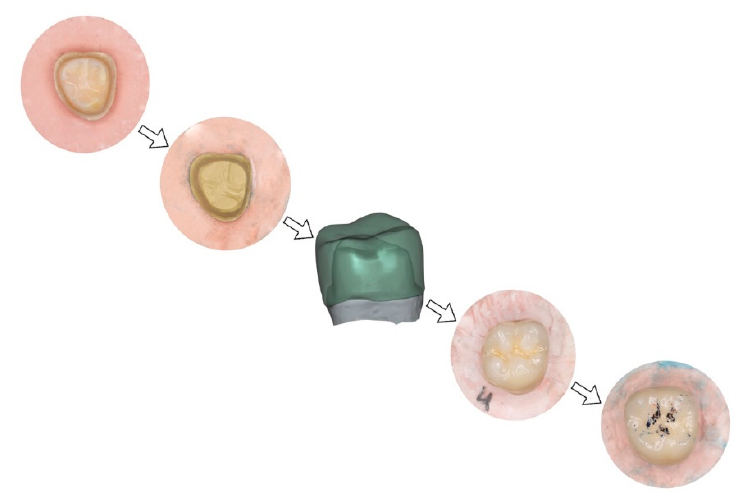
Figure 1. Process of design samples.